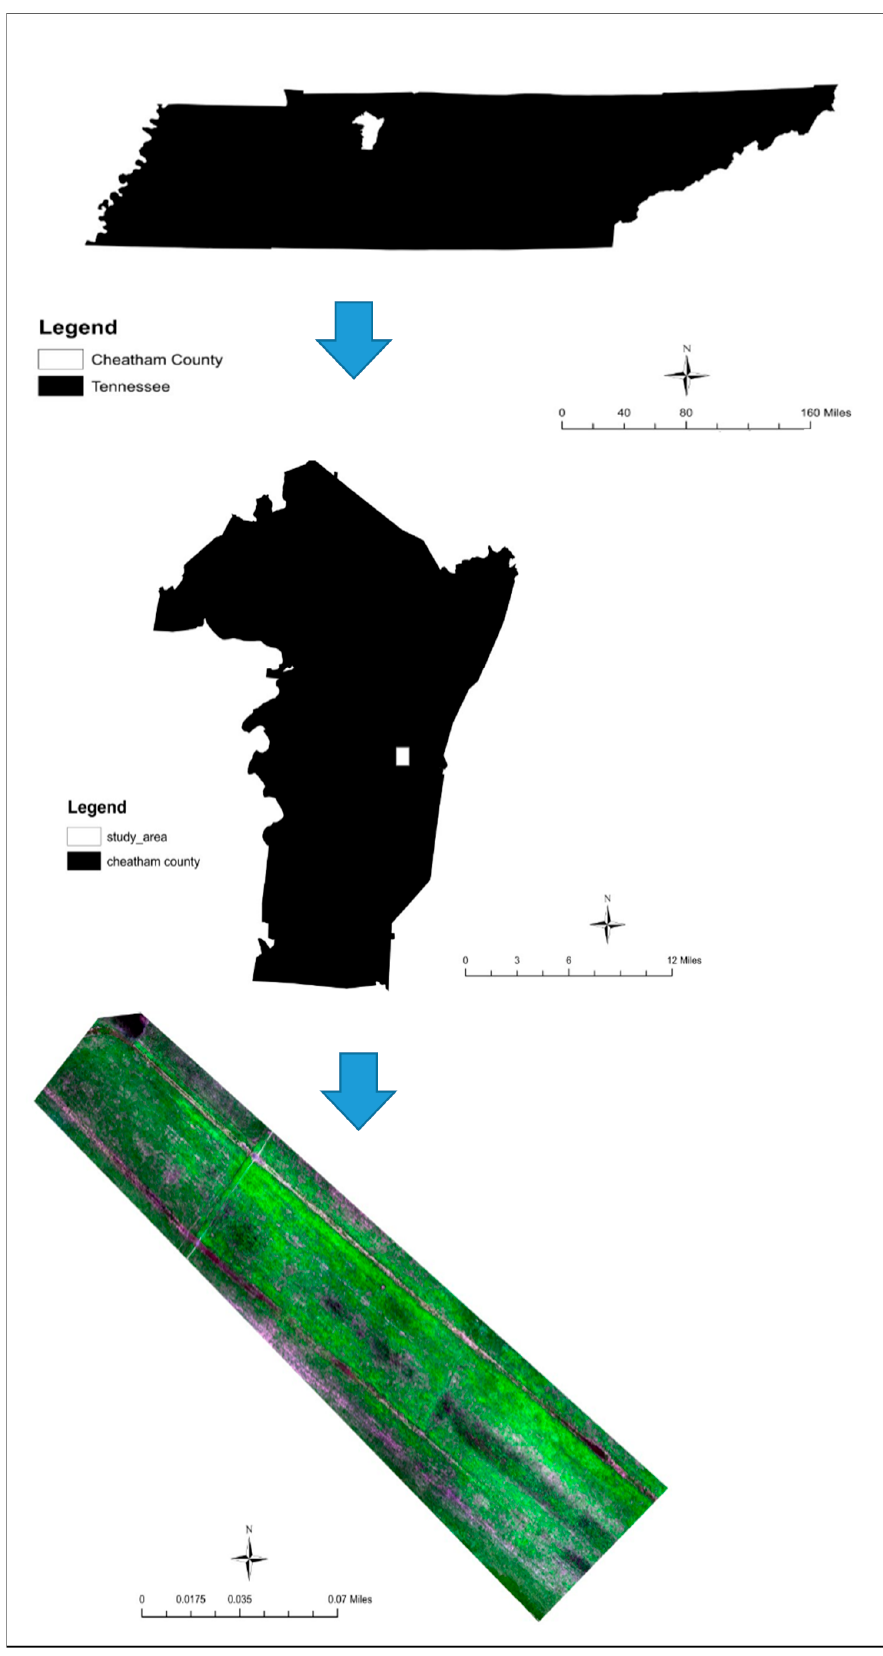
Figure 1. The location of the study area showing a drone aerial image of the grazing land area.